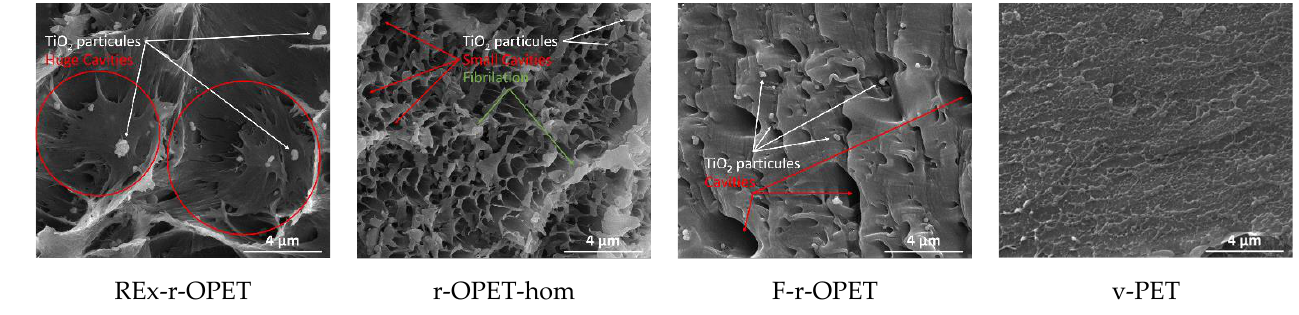
Figure 13. SEM images of fractured surfaces during T-T stressed at 95 %UTS (×20,000).